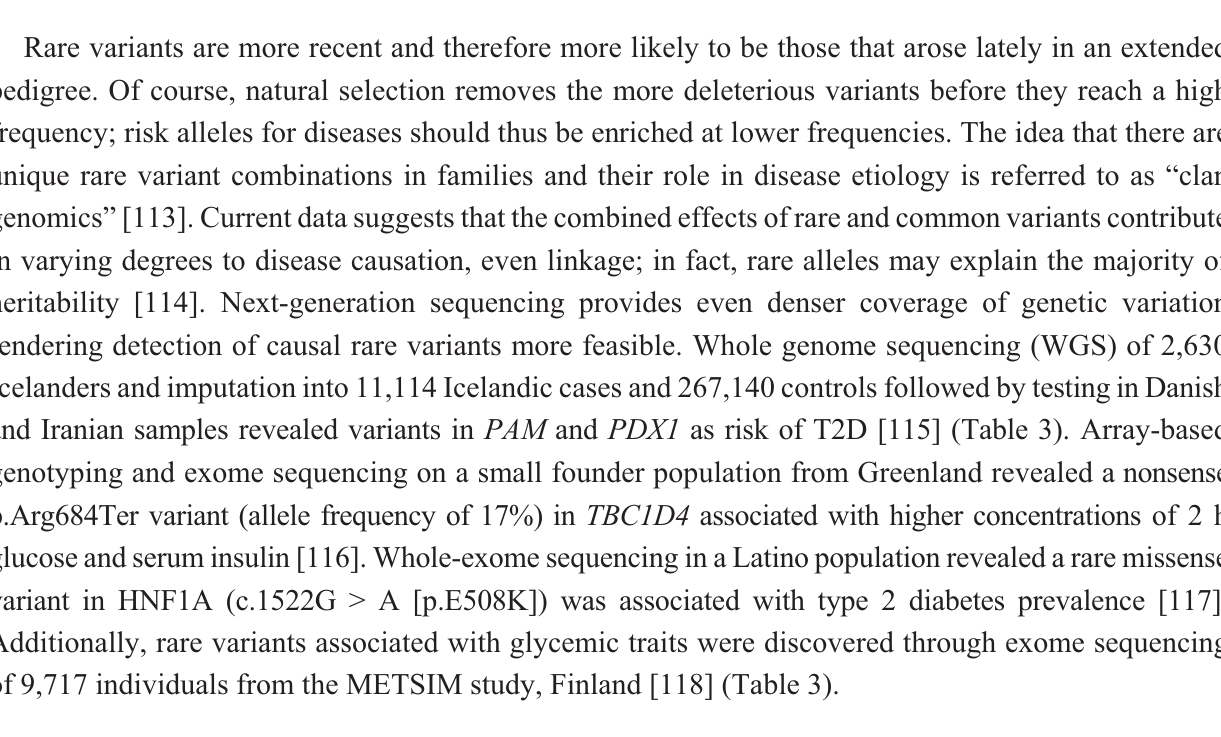
Table 3. Rare risk and protective loci associated with T2D and glycemic